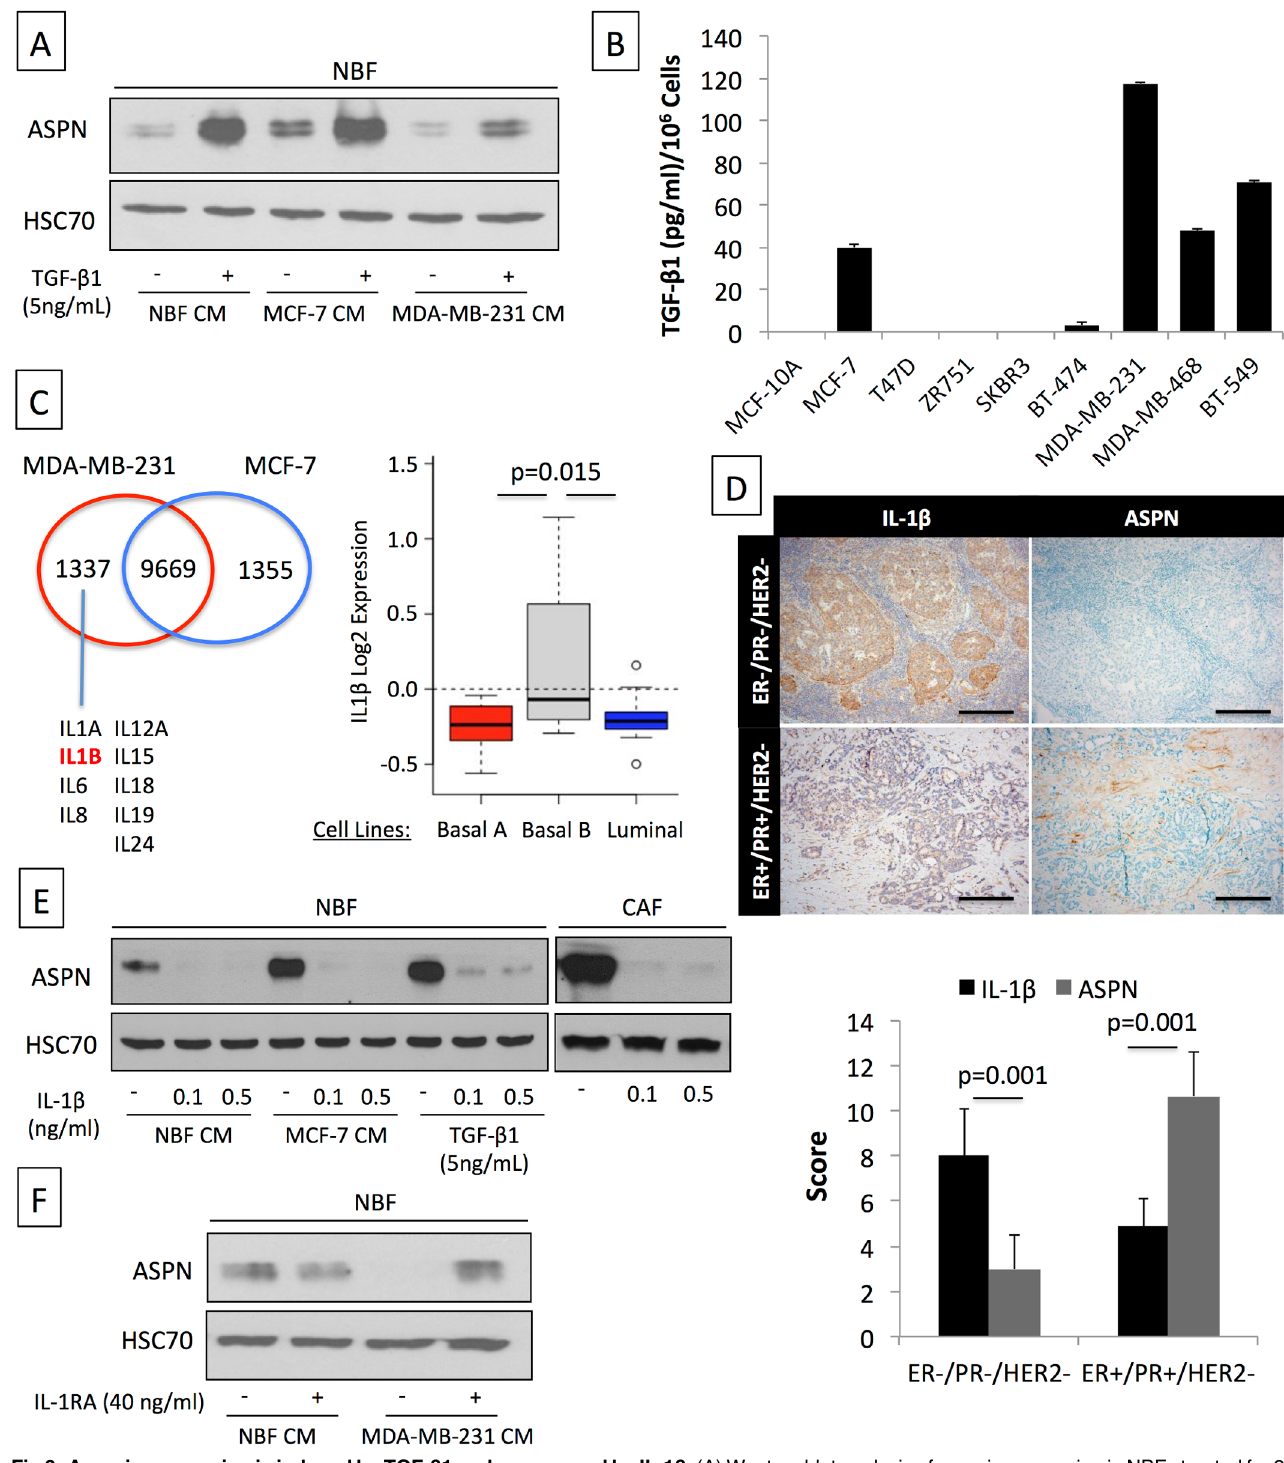
Fig 3. Asporin expression is induced by TGF- β 1 and suppressed by IL-1 β . (A) Western blot analysis of asporin expression in NBFs treated for 24 h with TGF- β 1 with or without CM of MCF-7 and MDA-MB-231 breast cancer cells. (B) ELISA quantification of TGF- β 1 levels secreted by human breast cancer cell lines during 48 h. (C) Differential in silico analysis of MCF-7 and MDA-MB-231 gene expression identifies a cluster of interleukins that are uniquely expressed in MDA-MB-231 cells (left panel). Analysis of IL-1 β mRNA expression using GOBO (http://co.bmc.lu.se/gobo/gsa.pl) across a panel of breast cancer cell lines [35] subdivided into three subtypes (right panel). (D) Representative IHC analysis (upper panel) of IL-1 β and asporin expression in a cohort of breast